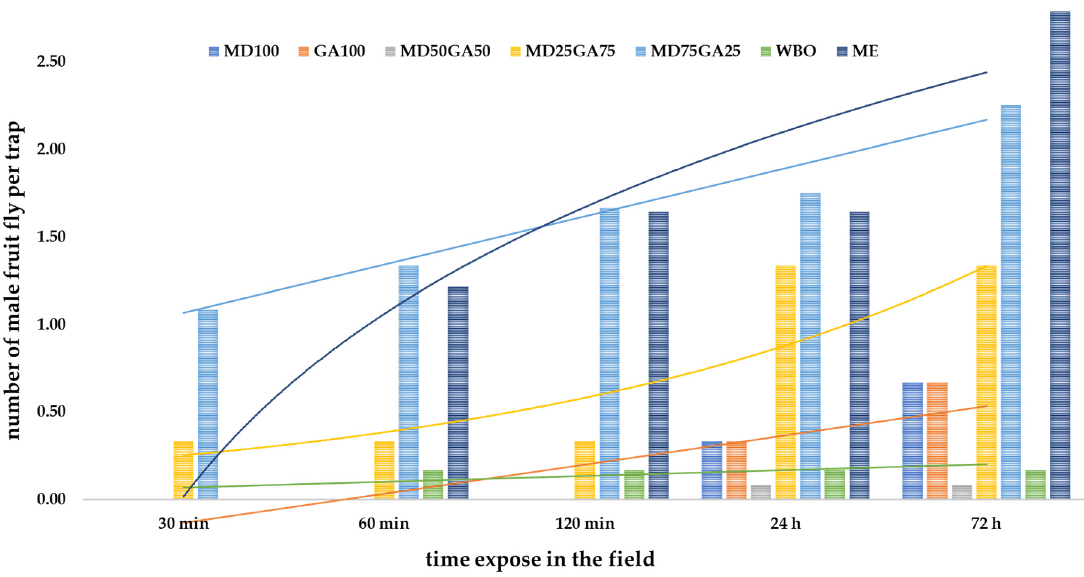
Figure 4. The trend of fruit flies caught by different lures at different times of field